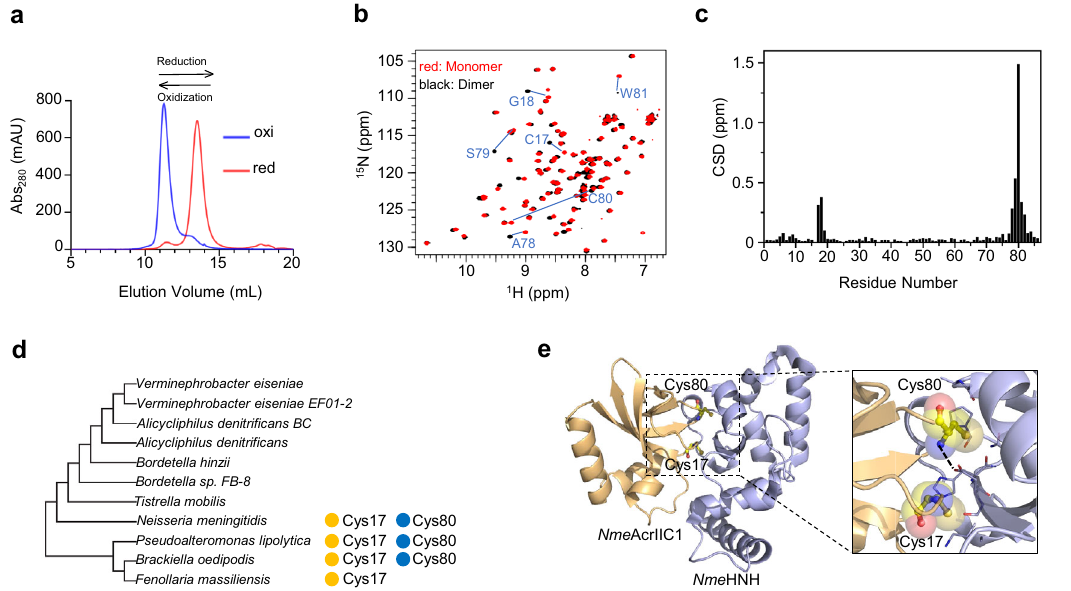
Fig. 1 | Nme AcrIIC1 can be oxidized into a dimer mediated by two conserved cysteines.a SECrunsshowthattheretentionvolumeof Nme AcrIIC1changesunder different redox conditions. When oxidized, Nme AcrIIC1 ’ s apparent molecular weight becomes twice as the reduced one, corresponding to a dimer (Supple- mentary Fig. 1a). b Overlay of 1 H- 15 N HSQC spectra for the oxidized dimer and the reducedmonomerof Nme AcrIIC1.Thepeaksfromthemonomerandthedimerare colored red and black, respectively. Residues with signi fi cant chemical shift dif- ference (CSD) between the two states are indicated with blue lines and labeled. c The bar diagram representing the composite CSDs ( 4 δ = ½ð δ HN Þ 2 + ð δ N = 6 : 51 Þ 2 (cid:2) 1 = 2 )